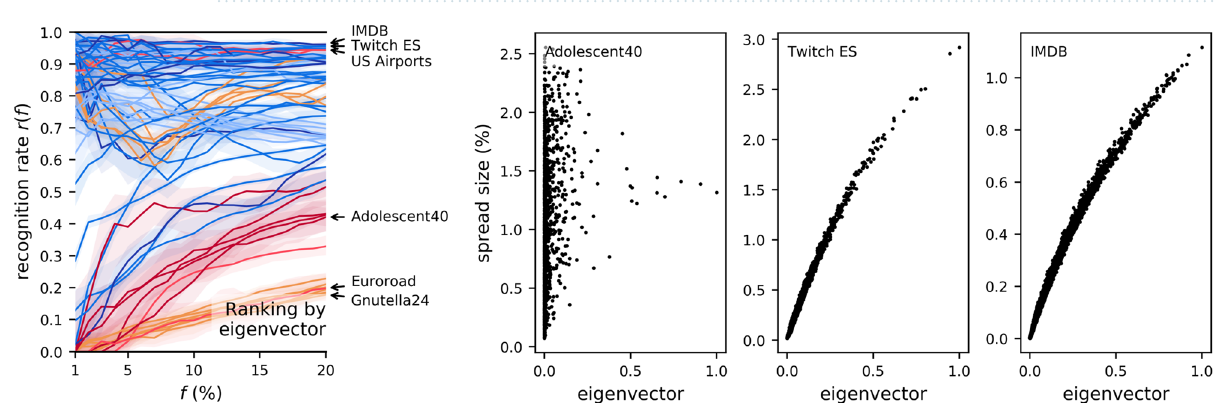
Figure 3. As Fig. 2, but with the core number as the ranker.